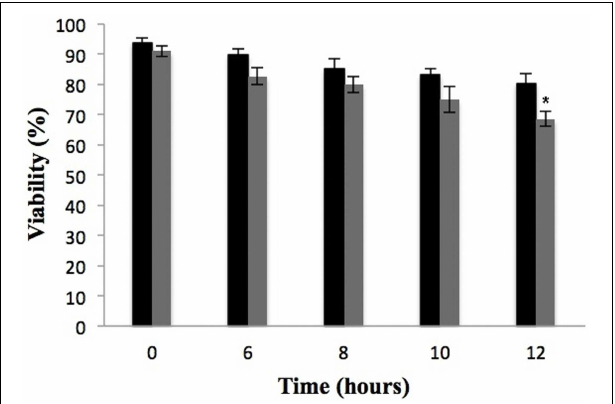
FIGURE 1 | Percentage of viable MRC5 normal human cells after exposure to different concentrations of argentilactone. Significance was accepted * p < 0 . 05 . Analysis was performed by a One-Way ANOVA followed by a Tukey post-test.